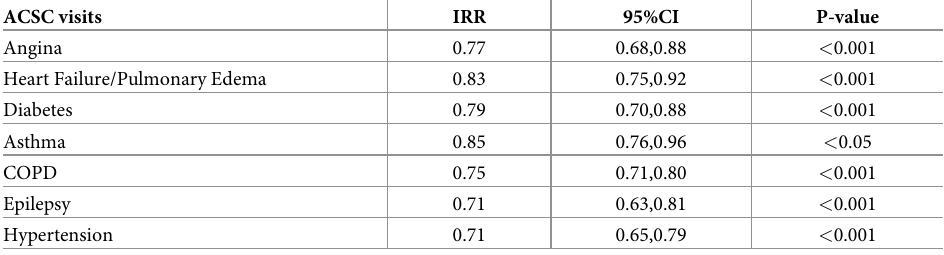
Table 3. Multivariable negative binomial regression with daily number of ED visits for ACSC comparing March 16-September 23, 2020 (post COVID-19 public health measures) to March 16-September 23, 2019.